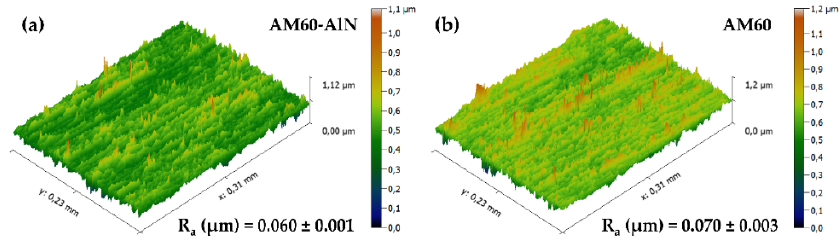
Figure 1. SEM images (×2000) of ( a ) AM60-AlN nanocomposite and ( b ) AM60 alloy reference sam- ples [44].